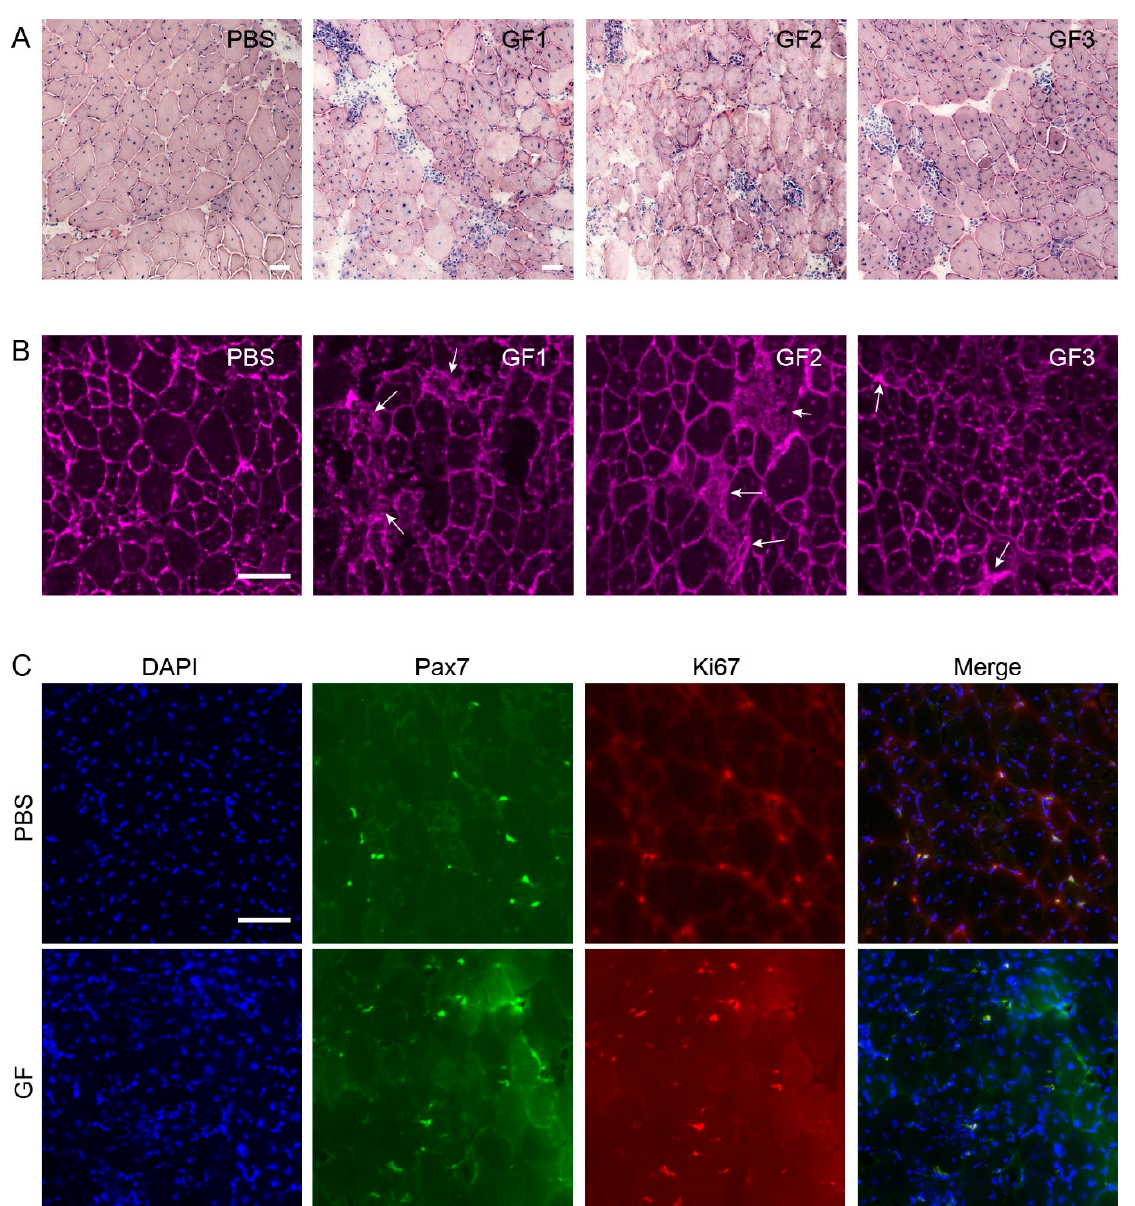
Figure 7. Effect of treatment on histopathology. H&E, WGA, and IHC stains of treated (GF) versus controls (PBS) mdx animals. ( A ) H&E stains demonstrate fiber size variation, focal inflammation, and necrotic fibers in treated animals compared to controls. ( B ) WGA showed increased fibrosis (arrows) in treated animals. ( C ) DAPI (blue), Pax7 (green), and Ki67 (red) showed activation of satellite cells. Bars represent 50 mm.